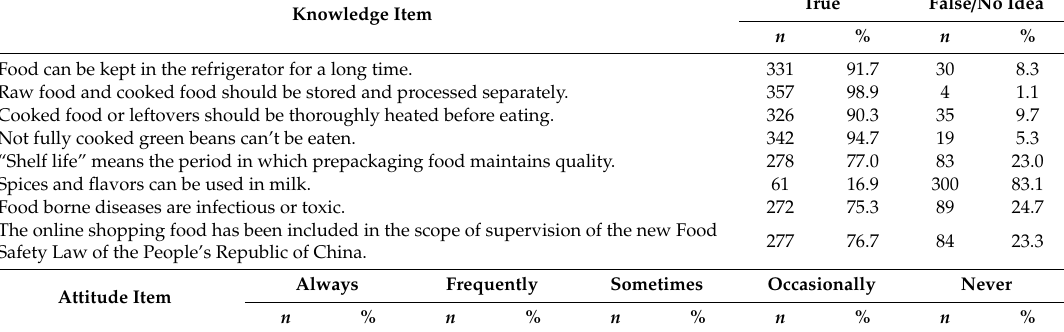
Table 2. Description of food safety behavior ( n =